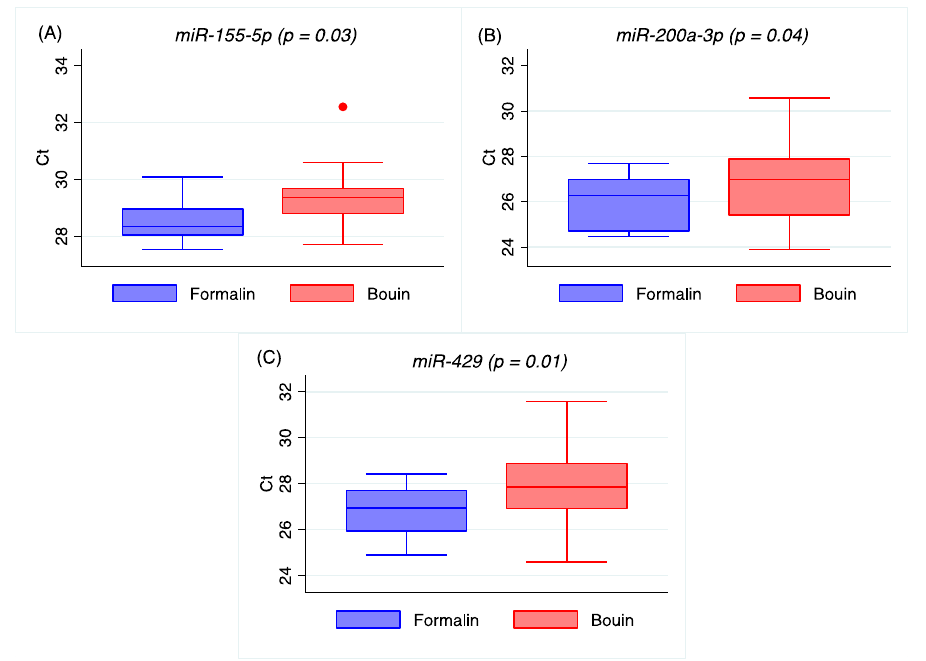
Figure A2. Box plot representing quantitative reverse transcription polymerase chain reaction (RT/qPCR) of miR-155-5p ( A ), miR-200a-3p ( B ), and miR-429 ( C ) in matched formalin- and Bouin’s-fixed tissues by real-time PCR. The box represents the first and third quartiles, intersected by the median, and the whiskers are the range. Int. J. Mol. Sci. 2019 , 20 , x FOR PEER REVIEW